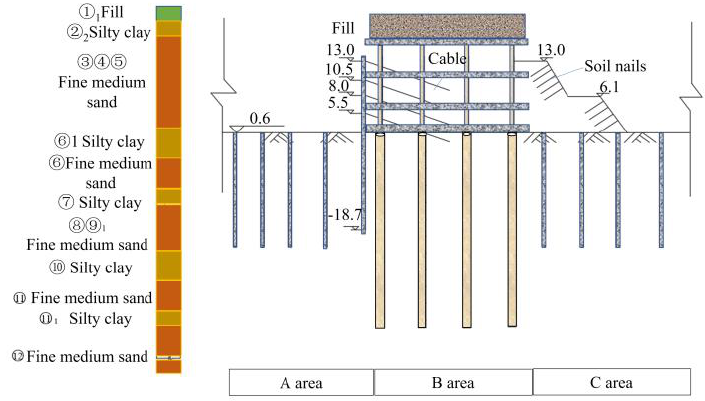
Figure 3. The cross − section along the south − north direction of pit (1 − 1). Table 2. Physical and mechanical parameters of structures.